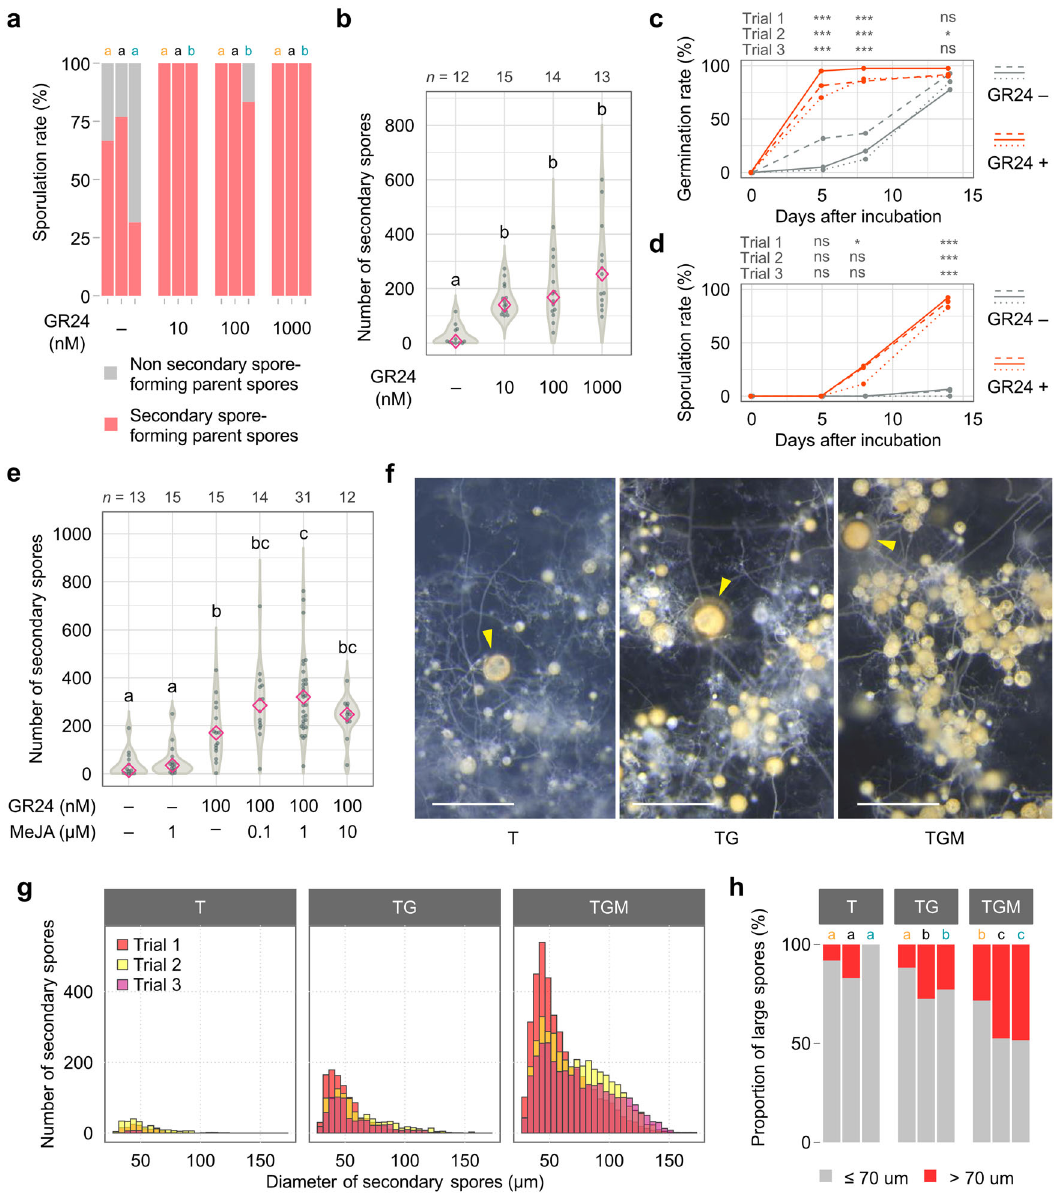
Fig. 2 Effects of phytohormones on asymbiotic cultures of R. clarus . All culture media contain both 500 µ M Myr-K and 1 g l − 1 peptone. a Percentage of secondary spore-forming parent spores relative to germinated parent spores in cultures with different concentrations of GR24 (10, 100, 1000 nM) at 6 WAI. Three bars in each condition are trials 1 to 3, respectively from the left. Different letters above the graph indicate signi fi cant differences among treatments in each trial by Fisher ’ s exact test with Bonferroni correction ( p < 0.05). b Numbers of secondary spores in cultures with different concentrations of GR24 (10, 100, 1000 nM) at 6 WAI. Diamonds indicate medians. Statistical signi fi cance was calculated using the Wilcoxon rank-sum test with Bonferroni correction ( p < 0.05). c , d Time course of germination rate ( c ) and sporulation rate ( d ) in media with and without 100 nM GR24. Dashed, solid and dotted lines indicate trials 1 – 3, respectively. Asterisks above graphs indicate signi fi cant differences between treatments in each trial using Fisher ’ s exact test with Bonferroni correction. *** p < 0.001; *0.01 ≤ p < 0.05; ns, not signi fi cant. DAI days after incubation. e Numbers of secondary spores in cultures with different concentrations of methyl jasmonate (MeJA, 0.1, 1, 10 µ M) and 100 nM GR24 at 6 WAI. Diamonds indicate medians. Different letters indicate signi fi cant differences (Wilcoxon rank-sum test with Bonferroni correction, p < 0.05). f Secondary spores generated from a single parent spore in T (500 µ M Myr-K, 1 g l − 1 peptone), TG (500 µ M Myr-K, 1 g l − 1 peptone and 100 nM GR24) and TGM media (500 µ M Myr-K, 1 g l − 1 peptone, 100 nM GR24 and 1 µ M MeJA) at 8 WAI. Arrowheads indicate parent spores. Large secondary spores were frequently observed in the medium containing both GR24 and MeJA (TGM) than in only GR24 (TG). Many brown spores were observed in TGM and TG media compared to the medium without the phytohormones (T). Bars = 500 µ m. g Size distribution of secondary spores produced from 8 parent spores in T, TG and TGM media at 8 WAI. h Percentage of large spores (>70 µ m in diameter) in secondary spores produced in T, TG and TGM media at 8 WAI. Different letters indicate signi fi cant differences among treatments in each trial using Fisher ’ s exact test with Bonferroni correction ( p < 0.05). p -values are described in Supplementary Data